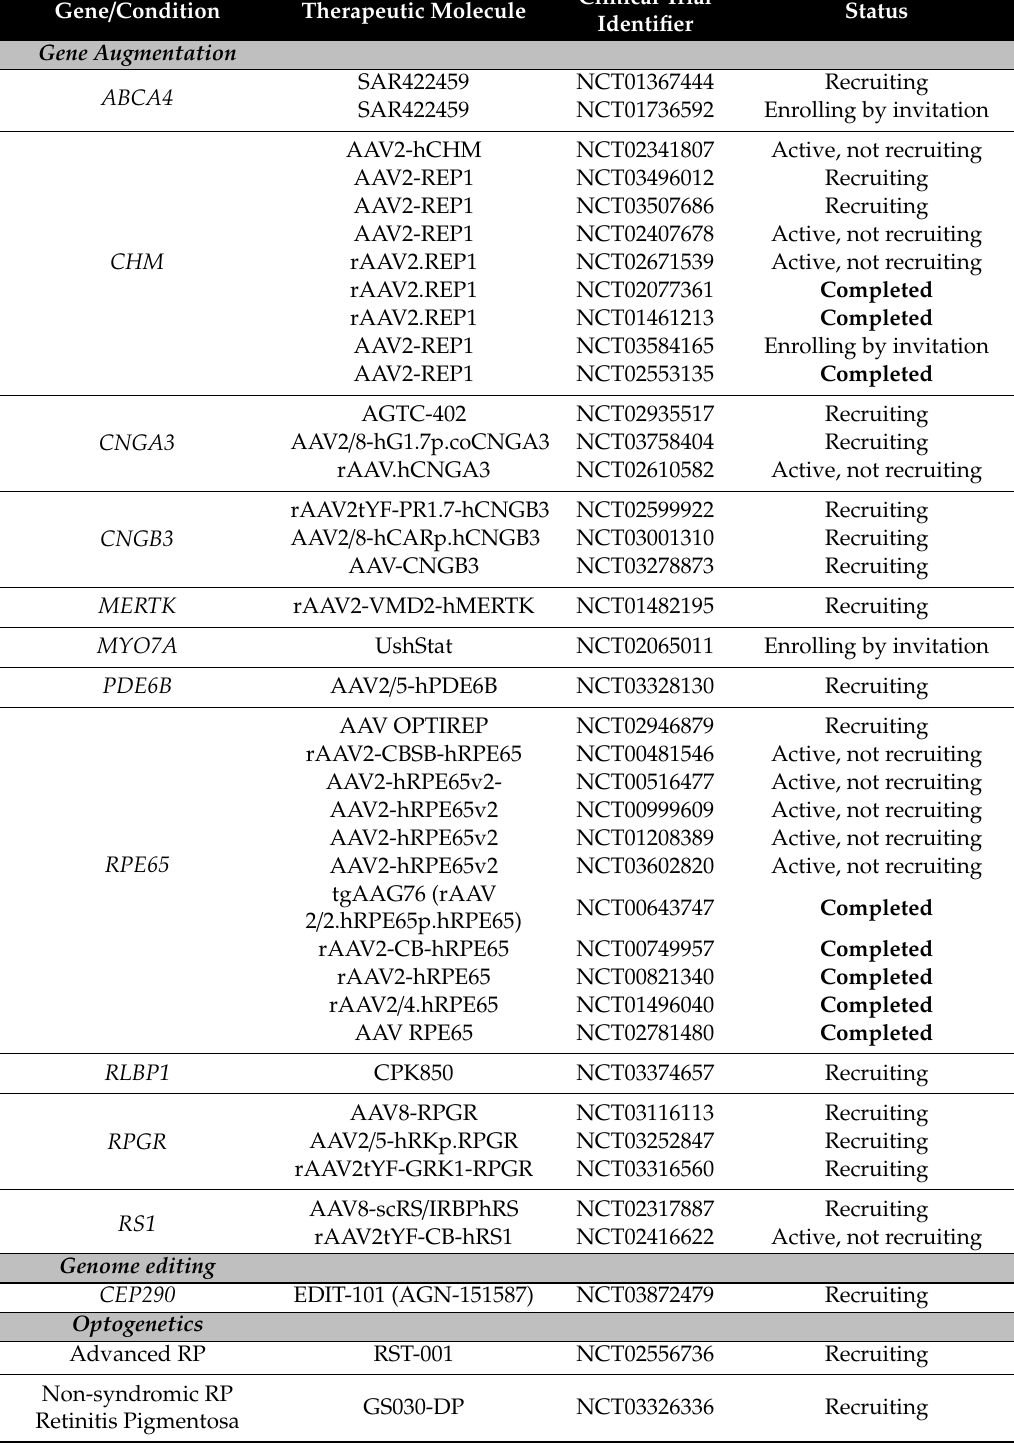
Table 1. Summary of clinical trials for inherited retinal diseases (IRDs) using DNA